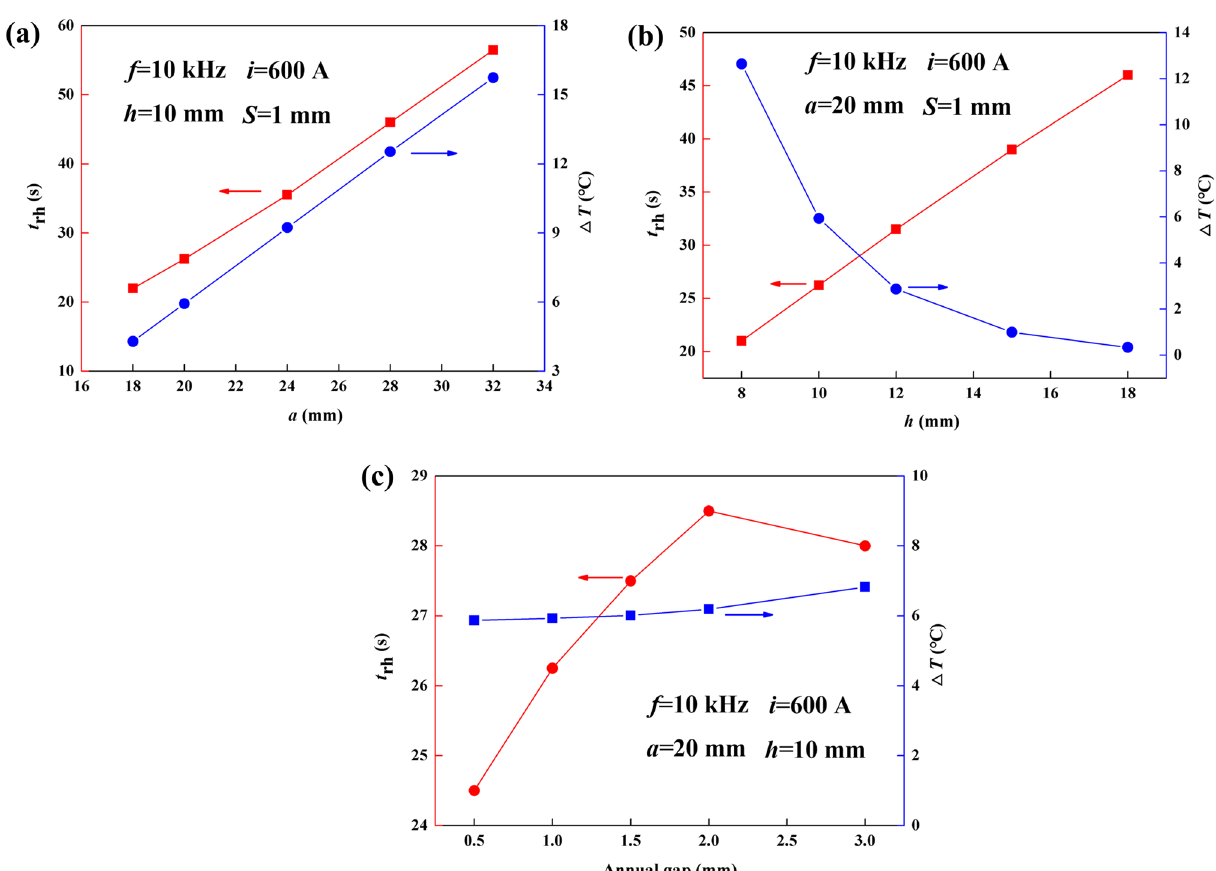
Fig. 4 Effect of parameter a ( a ), h ( b ) and S ( c ) on mold thermal response